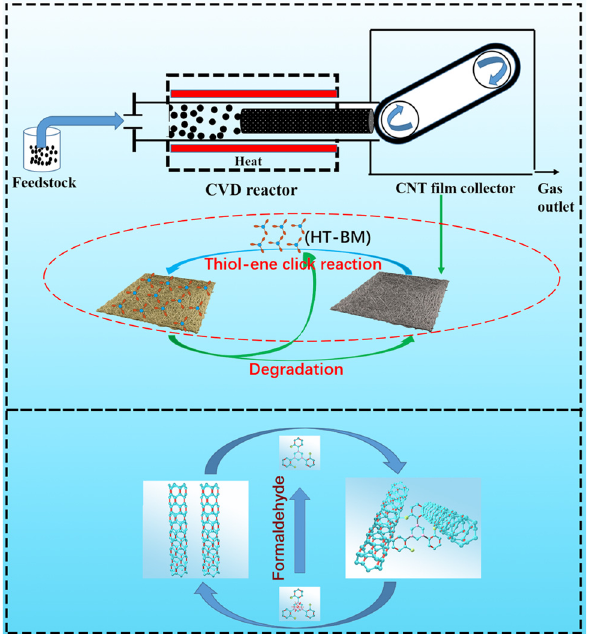
Figure 1: Closed - loop process thiol - functionalized CNT fi lm for recycling both CNT fi lm and